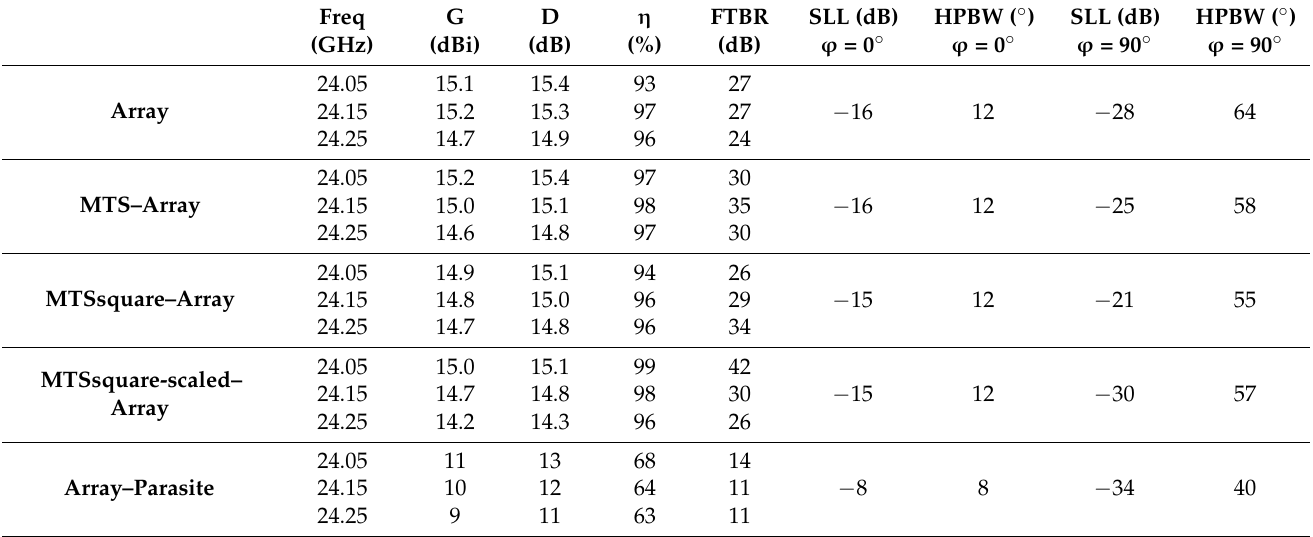
Table 1. Radiation properties for the array antenna alone and combined with metasurfaces and